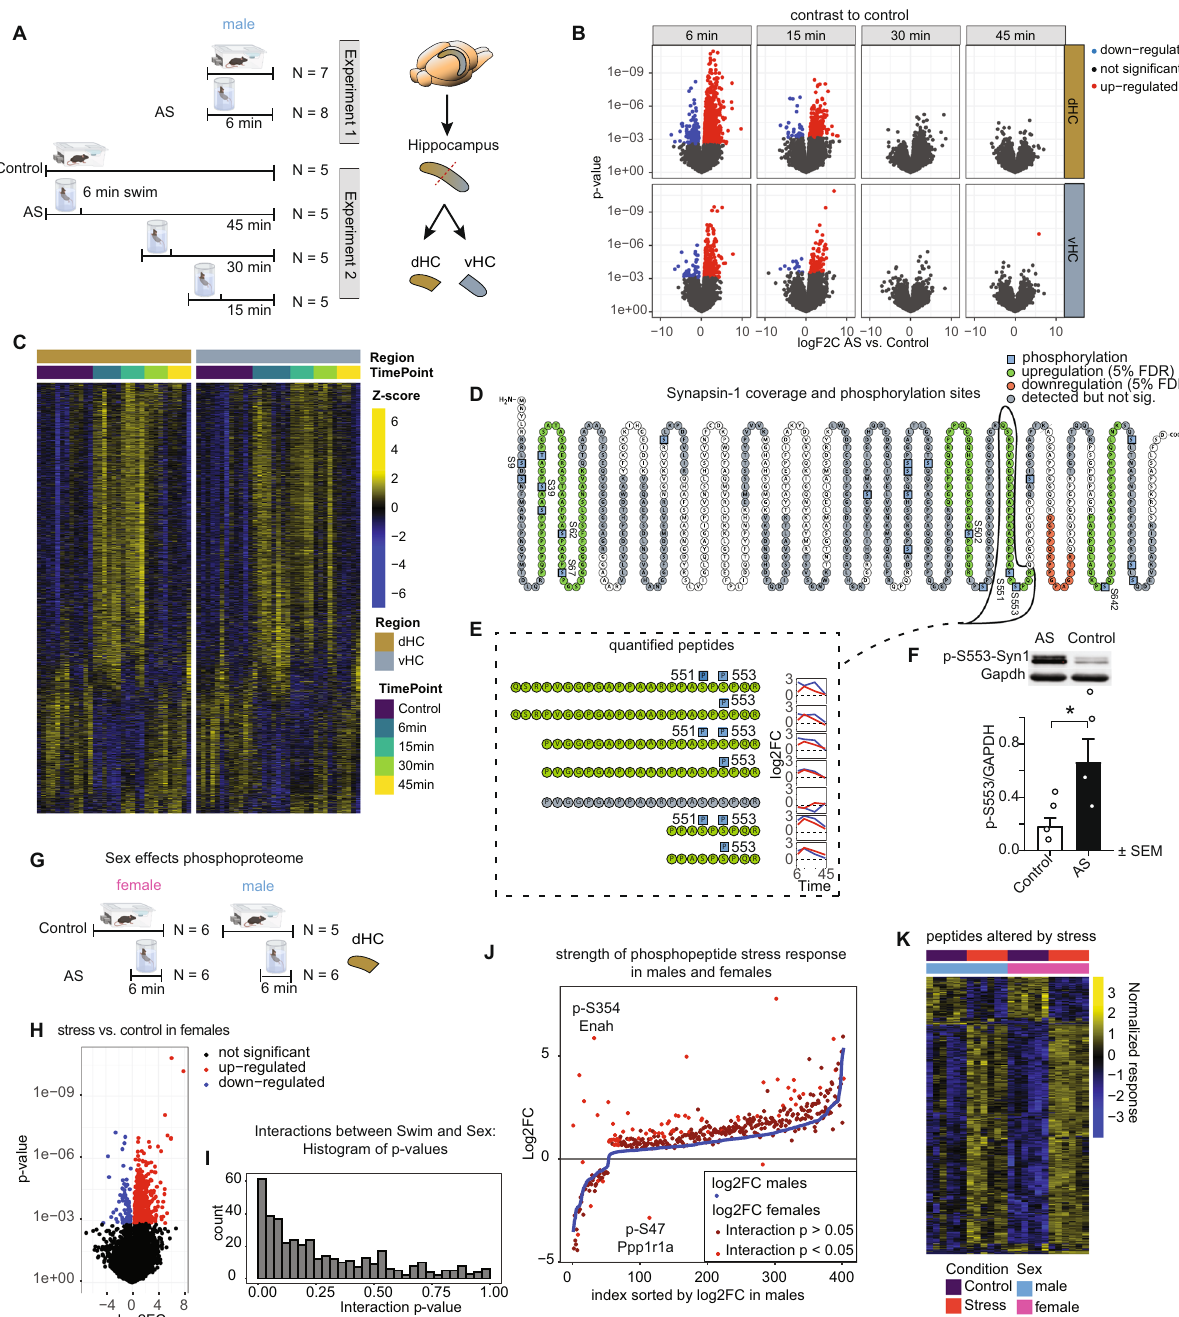
Fig. 1 Rapid, short-lived effects of acute stress (AS) on the phosphoproteome of the dorsal hippocampus (dHC) and ventral hippocampus (vHC). A Experimental design and tissue collection approach. B Volcano plots showing the estimated log2 fold changes and statistical test results for modi fi ed peptides immediately (Exp. 1) or shortly (Exp. 2) after exposure to AS. Red and blue dots represent signi fi cant changes within 5% false discovery rate (FDR) relative to non-stressed controls. C Heatmaps showing the abundance of signi fi cantly modi fi ed peptides across all samples. D Amino acid sequence of Synapsin 1, illustrating overall coverage (grey, green and red), phosphopeptides signi fi cantly upregulated (green) or downregulated (red) at any time point after AS and detected phosphosites (blue, probability of post-translational modi fi cation >0.75). E Quanti fi cation of all detected Synapsin 1 modi fi ed peptides spanning sites pS551 and pS553, and their temporal pro fi les (blue = dHC, red = vHC). F Validation of the upregulation of the phosphorylated site SYN1-pS553 with Western blot in the dHC immediately after stress (Effect size ~300%, t(6) = 2.40, p = 0.037, one-tailed unpaired t test, N = 4 mice/ group). Data represent mean ± SEM. Source data are provided as a Source Data fi le ( G ) Experimental design of tests for phosphoproteomic sex differences. H Volcano plots showing the estimated log2 fold changes and statistical test results for modi fi ed peptides immediately after stress exposure in female mice. Red: signi fi cant upregulation (FDR adj. p < 0.05), blue: signi fi cant downregulation (FDR adj. p < 0.05) ( I ) Histogram of interaction p values of all stress or sex responsive phosphopeptides. J AS vs ctrl log2FCs in males (blue) and females (red) sorted by stress response strength in males. Phosphopeptides with signi fi cant AS:Sex interaction are labeled in bright red. K Stress responsive phosphopeptides in male and female dHC immediately after stress. * p <